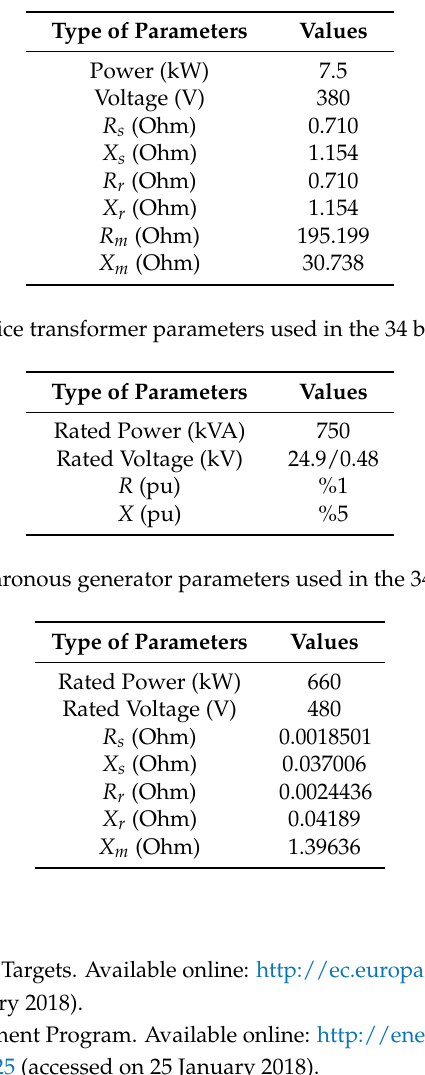
Table A1. Asynchronous generator parameters used in the experimental system.